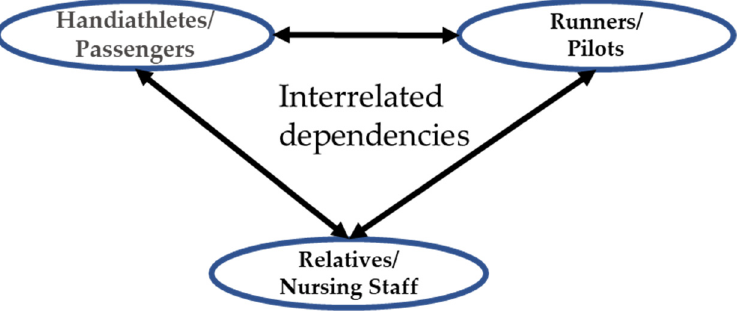
Table 1. Prioritised target groups of interest according to the two programmes the TT and CWA, respectively, Target Group